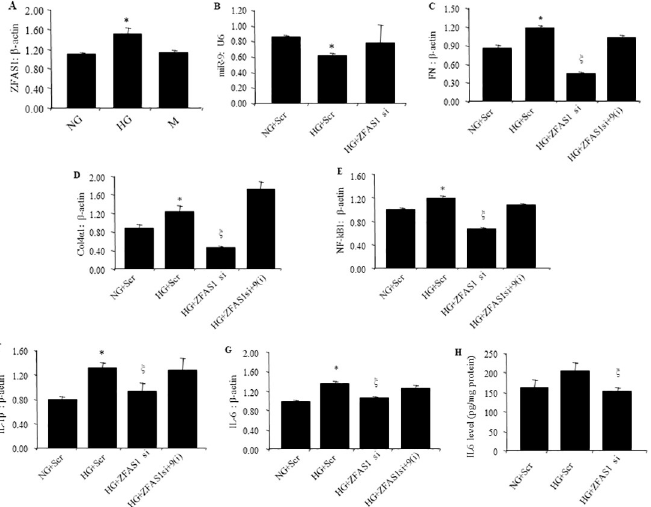
Fig 2. Effects of ZFAS1 silencing on mRNA levels of ECM and proinflammatory factors in HCMECs. (A) ZFAS expression was increased in HG along with B) reduced miR9 expression., Treatment of HCMECs with HG also increased the mRNA expression of ECM proteins C) FN and D) Col 4a1, proinflammatory factors markers E) NF-kB1 (F), IL-1 β and (G) IL-6, compared with NG along with H) IL-6 protein levels. Suppression of ZFAS1 reversed these alterations (B-H). Rescue experiments showed that (C-G) ZFAS1siRNA induced recovery can be reversed by miR-9 antagomir (A-E). (RNA data are expressed as a ratio to β -actin; mean ± SEM. � p < 0.05 vs NG+Scr; ξ p < 0.05 vs